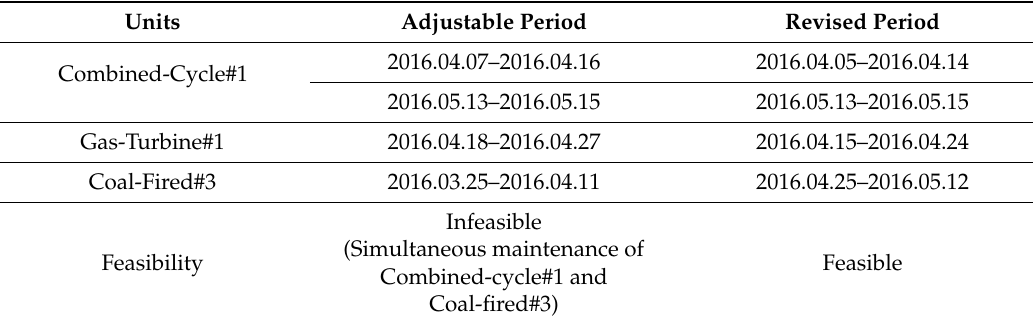
Table 4. Results of feasibility check for must-run units in Group